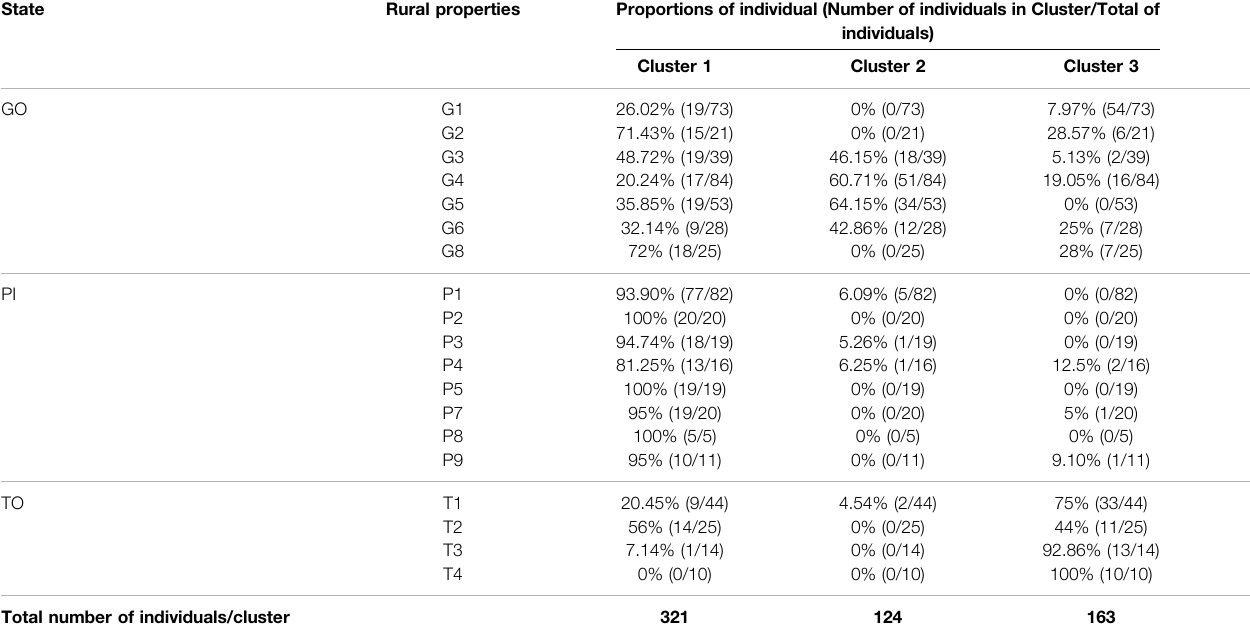
TABLE 3 | Locality of cattle assigned to clusters 1, 2, and 3 of breed genetic similarity for the Curraleiro Pé-Duro